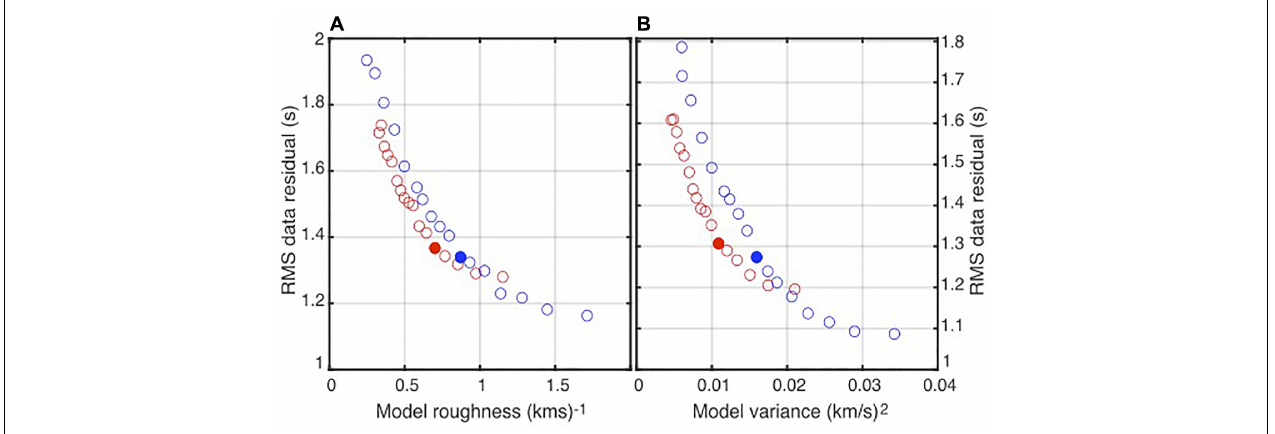
FIGURE 4 | The trade-off curves between misfit and model roughness for different smoothing parameters (A) and the trade-off curves between misfit and model variance for different damping parameters (B) for periods of 5 s (red) and 20 s (blue). Damping and smoothing parameters change in the range between 0 and 5. The selected optimal smoothing and damping parameters are shown by filled